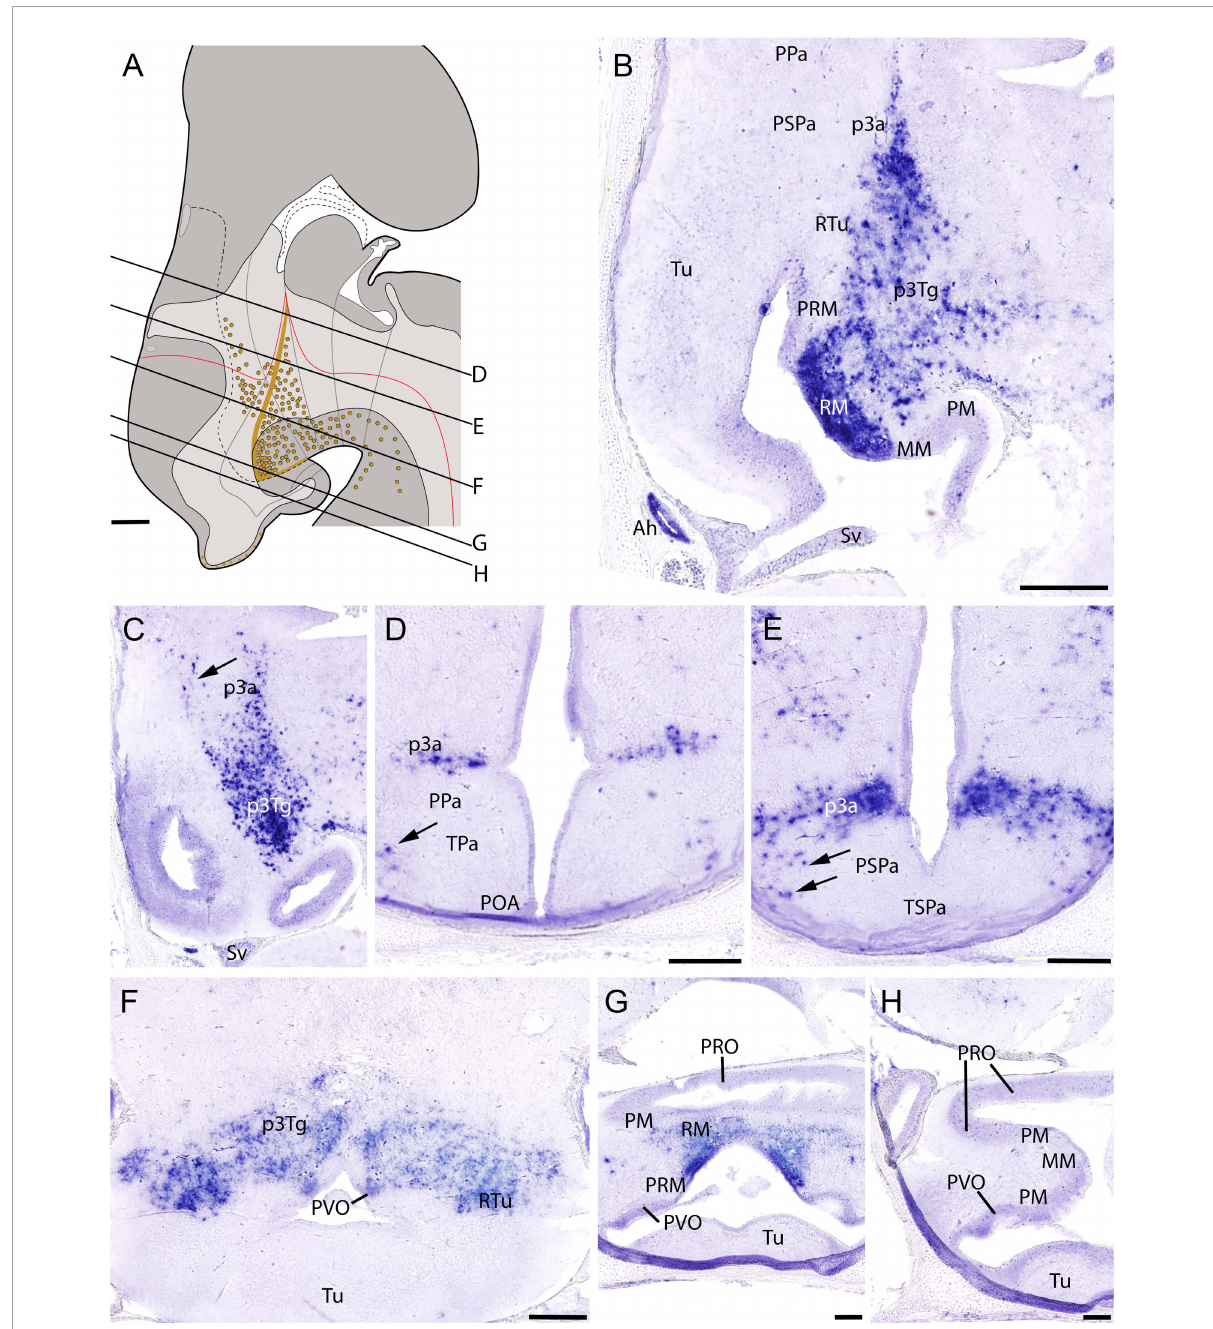
FIGURE5 Regionalization of the hypothalamus of Scyliorhinus canicula at stage 32 based on the expression of ScPitx2 (orange color in A ) by means of in situ hybridization ( B–H ) in sagittal ( B,C ) or transverse ( D–H ) sections. Scheme on (A) represent a maximal projection of the expression found in sagittal and parasagittal sections. Lines represent the level of transverse sections. Ventricular labeling is represented with solid color while mantle cells are represented with dots. For abbreviations, see list. Scale bars: 125 µ